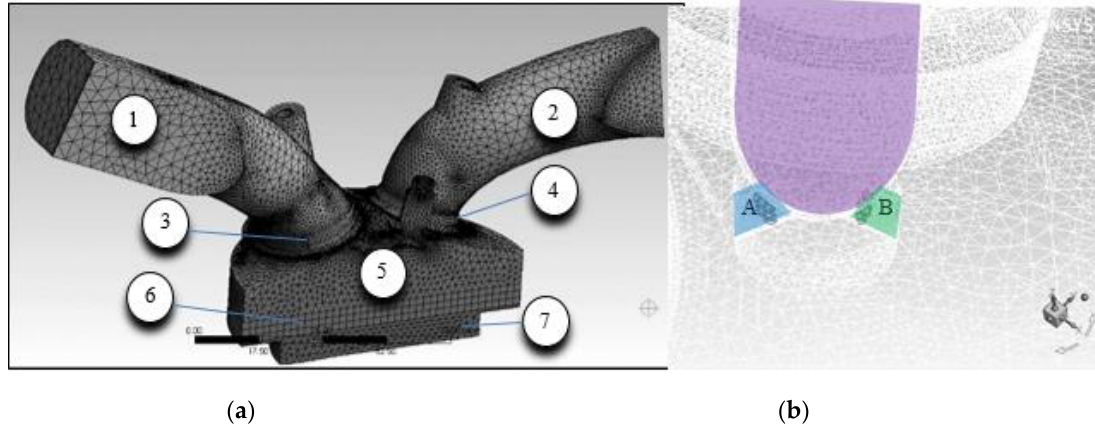
Figure 4. Decomposition model of the engine with prechamber: ( a ) Mesh of the cylinder head ( b ) Inlet-A, and outlet-B, ducts in the main body of the prechamber-C.